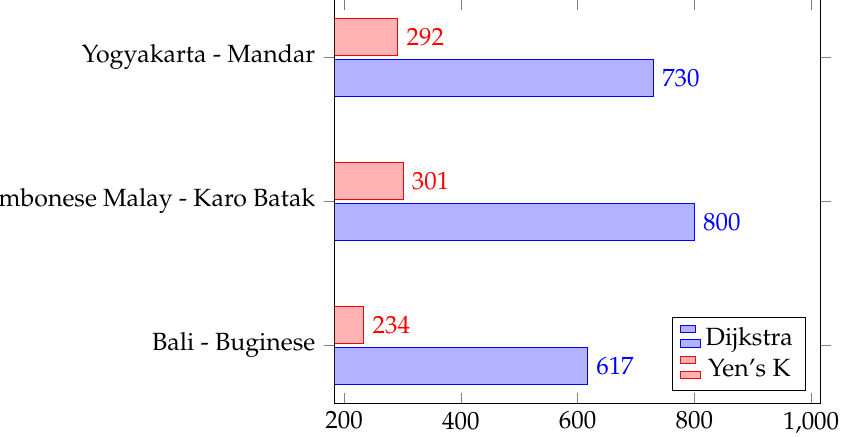
Figure 5. Performance comparison by execution time (ms).